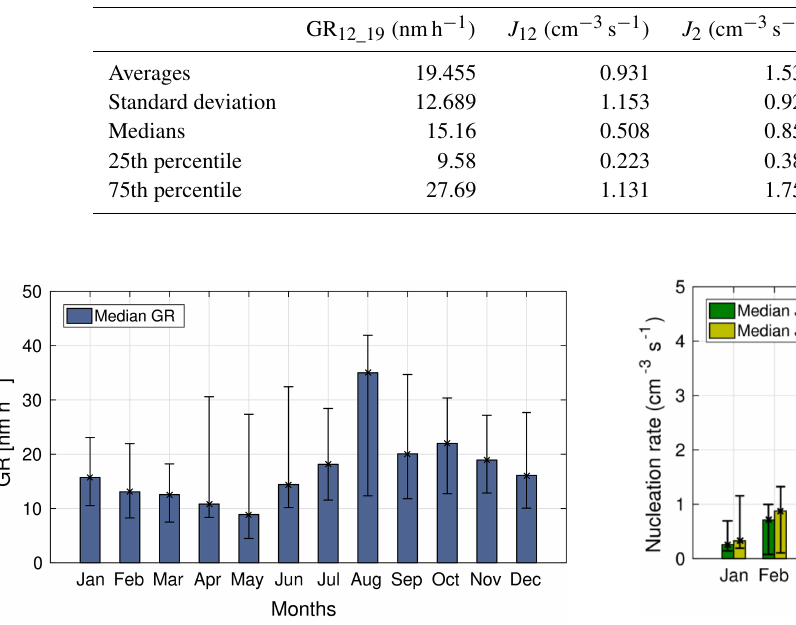
Figure 6. Monthly median growth rates in 2015. Error bars in black represent 25th percentile (top) and 75th percentile (base). To build these representation, 146 growth rates were estimated on 167 days classified as event days.